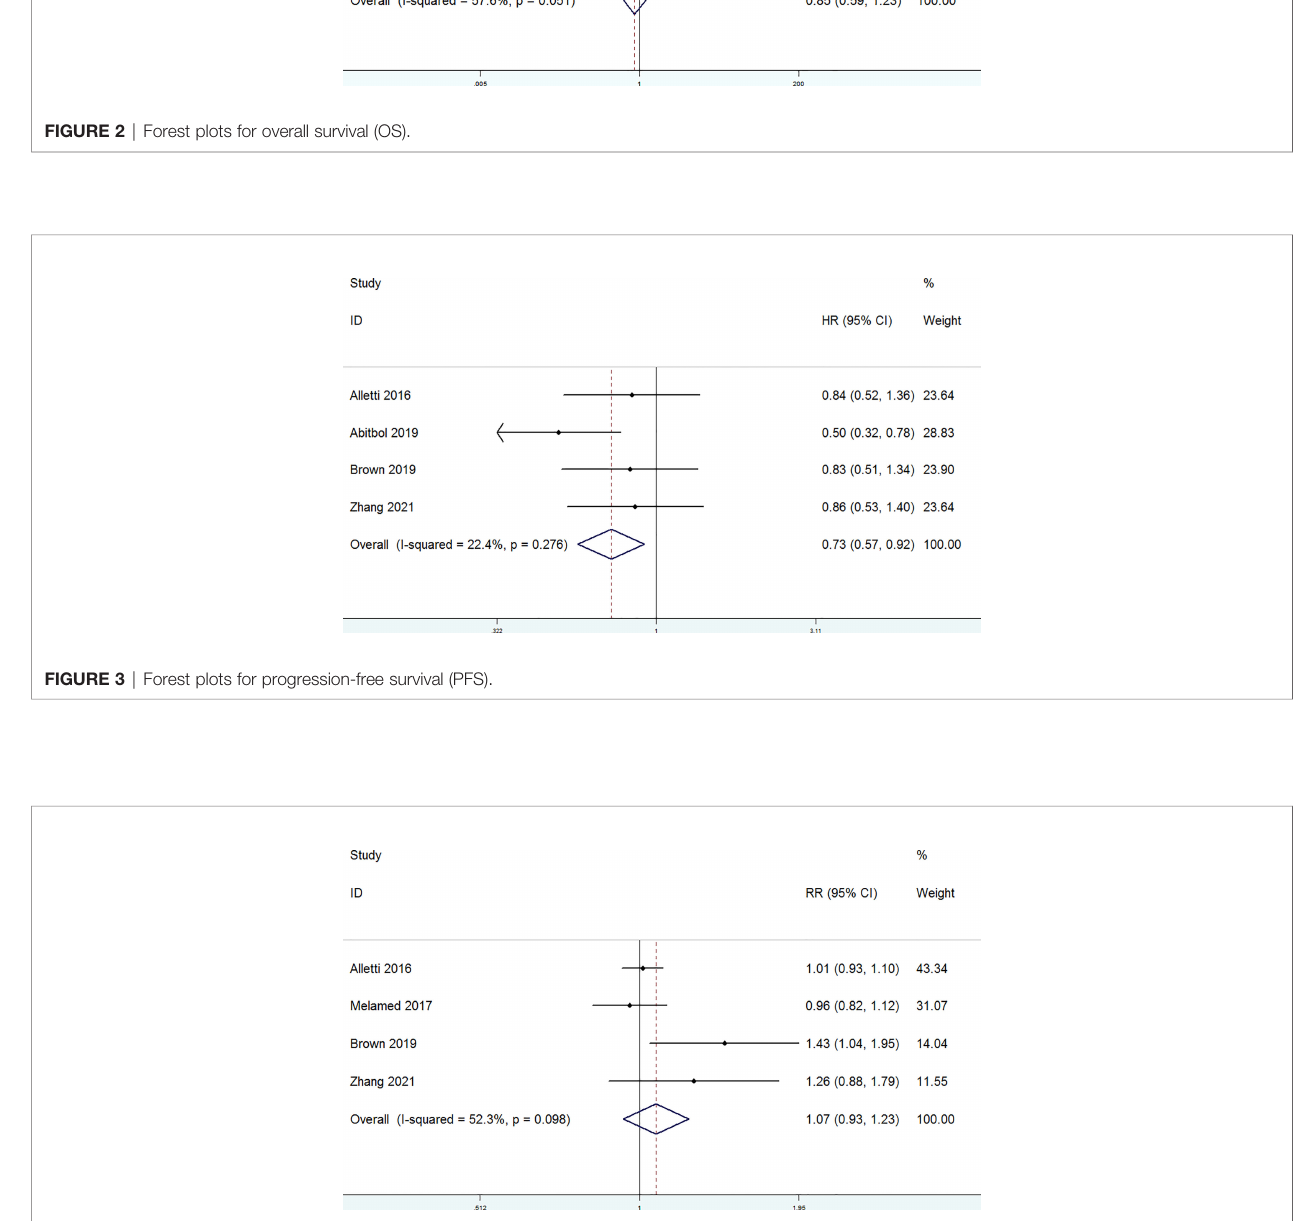
FIGURE 4 | Forest plots for completeness of debulking removal